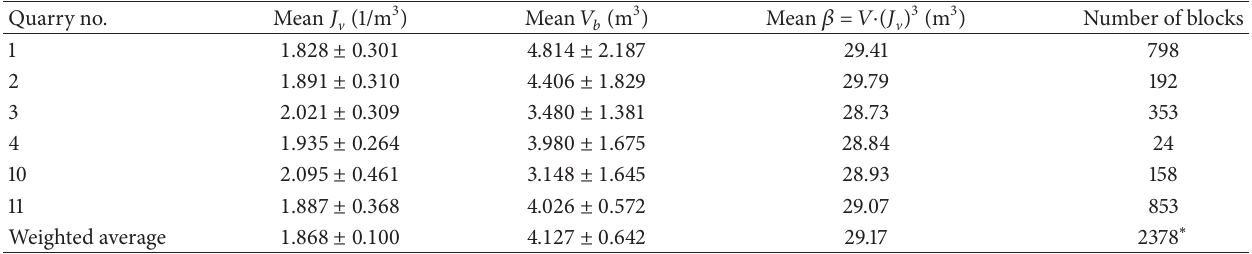
Table 5: The mean volumetric joint counts ( 𝐽 V ) mean block volume and the shape factor ( 𝛽 ) values for the limestone blocks produced in the Karaburun limestone